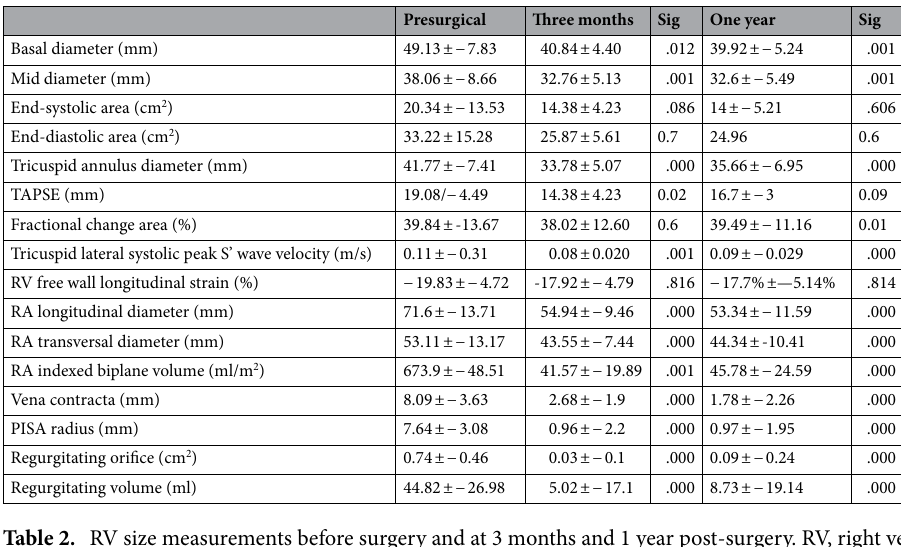
Table 2. RV size measurements before surgery and at 3 months and 1 year post-surgery. RV, right ventricle; RA, right atrium; TAPSE, tricuspid annular plane systolic excursion.